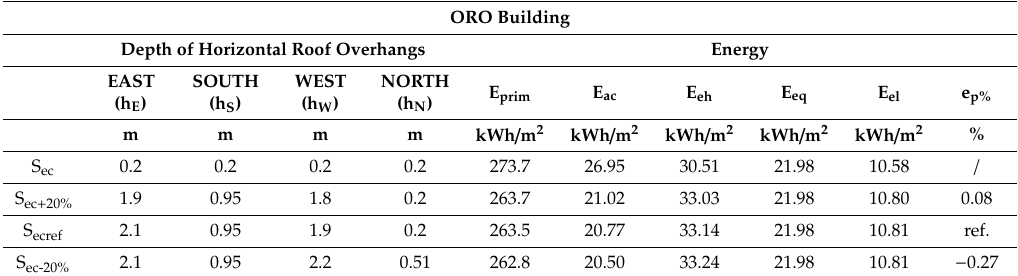
Table 7. Sensitivity to the accuracy of the specific embodied energy for OBO house. OBO Building Depth of Horizontal Balcony